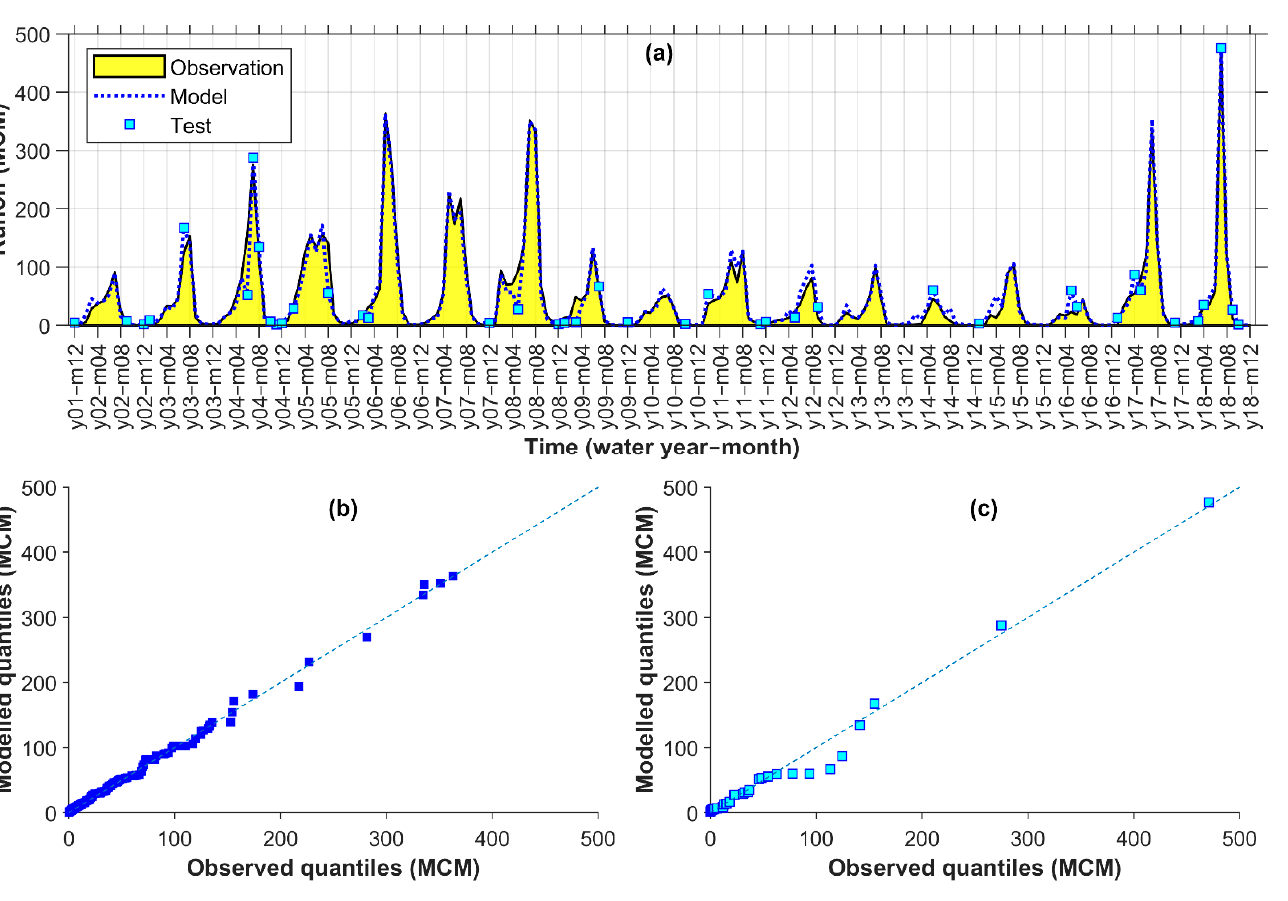
Figure 4. Gamasiab observed vs. modelled monthly runoff time series ( a ) and q–q plots for calibration ( b ) and test ( c ) points (MCM: million cubic meters). Table 5. Performance criteria values in test points for the selected (Comb. 7 Lag 0–2) vs. reference model (Comb. 5 Lag 0–2) for Gamasiab (RMSE and MAE are in million cubic meters, while the others are unitless) and the change rate (%) between them.